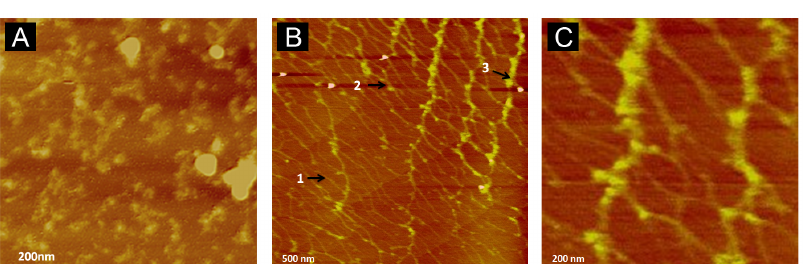
Figure 2. In situ AFM height images (3.0 6 3.0 m m) exhibiting absorption of rmOC90 and rhOtolin-1 on freshly cleaved mica. (A) rmOC90 sustains cluster formation randomly distributed on a mica surface after 48 hours of incubation. (B) rhOtolin-1 self assembled into a honeycomb network on a mica surface after 48 hours of incubation. rhOtolin-1 fibril height measurements reveal the presence of monomeric (arrow 1), dimeric (arrow 2) and trimeric (arrow 3) components. (C) An enlarged area of the matrix from panel B.